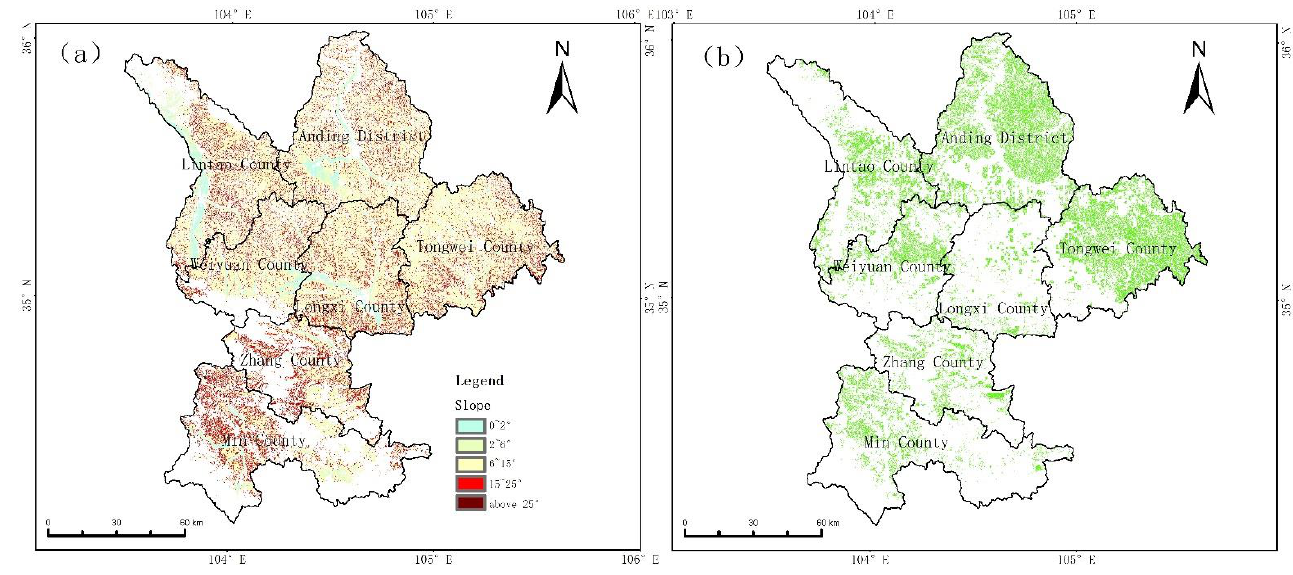
Figure 6. ( a ) Spatial distribution of cultivated land and its relationship with slope, and the ( b ) overlapping areas of cultivated land and important areas of soil conservation function. Table 4. Coupling analysis of the importance of cultivated land slope and soil conservation function (km 2 ).